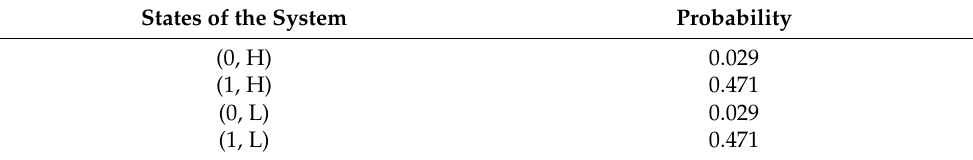
Table 16. Steady state of one active firm.